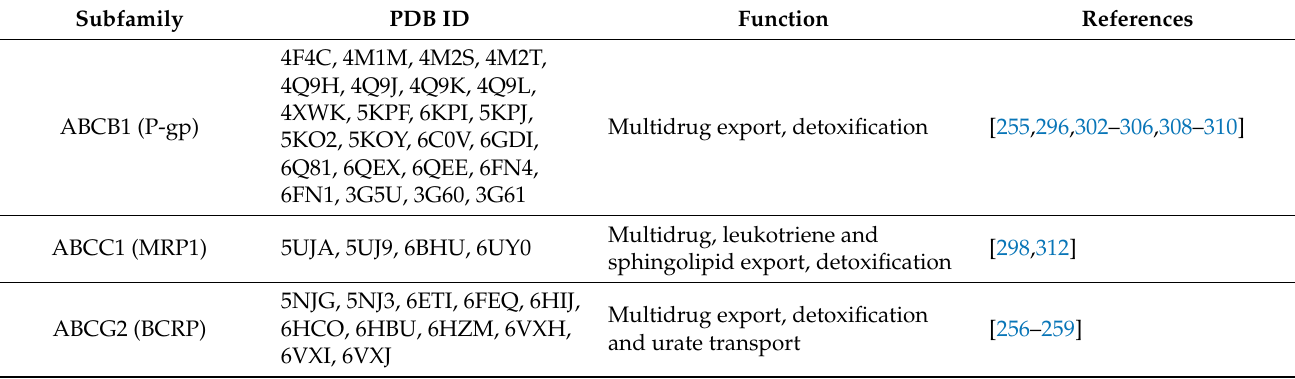
Table 3. Atomic structures of eukaryotic MDR ABC